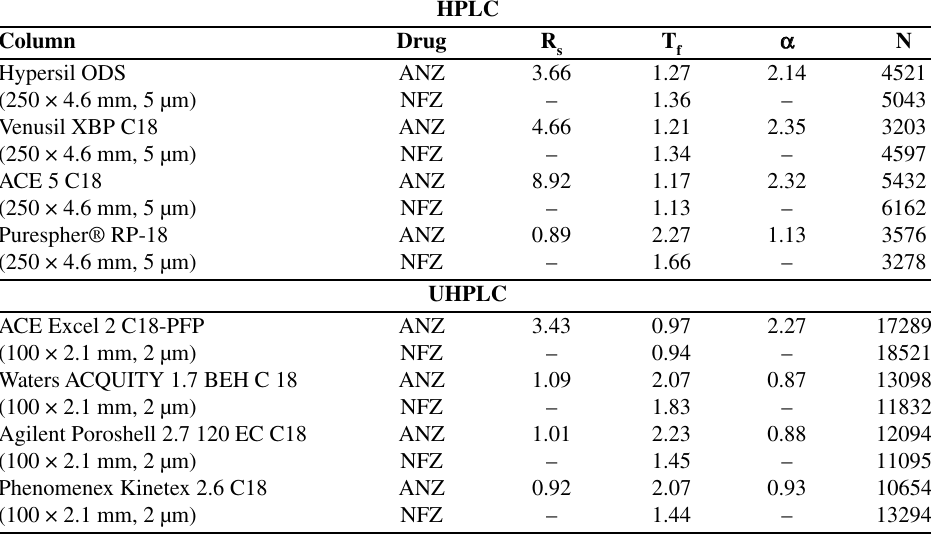
Table 1. Results of tested stationary